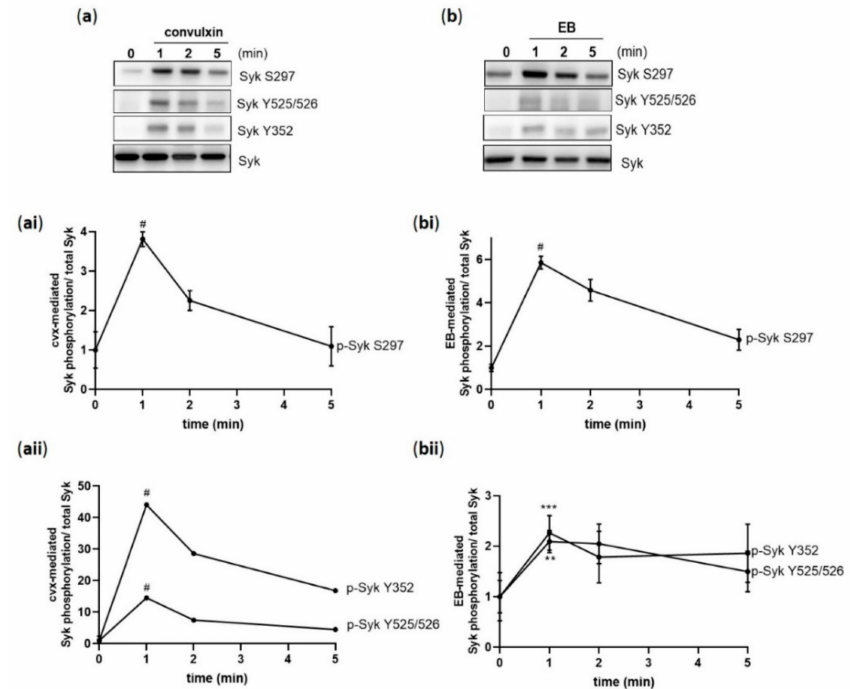
Figure 2. Cvx and EB induce a transient Syk S297 phosphorylation in parallel with Syk tyrosine phosphorylation. Washed human platelets were stimulated under stirring conditions with ( a ) 50 ng / mL cvx or ( b ) 0.5% ( v / v ) EB. ( ai , bi ) Syk phosphorylation on S297 and tyrosine sites (525 / 526 and 352) mediated by cvx or by EB were analyzed in a time-dependent manner (1, 2, and 5 min) compared to total Syk. ( aii , bii ) The kinetics of the phosphorylation patterns are represented as means ± SD from three independent experiments with platelets from three healthy donors. # p < 0.0001, *** p < 0.001, ** p < 0.01, untreated versus cvx-or EB-stimulated platelets at 1